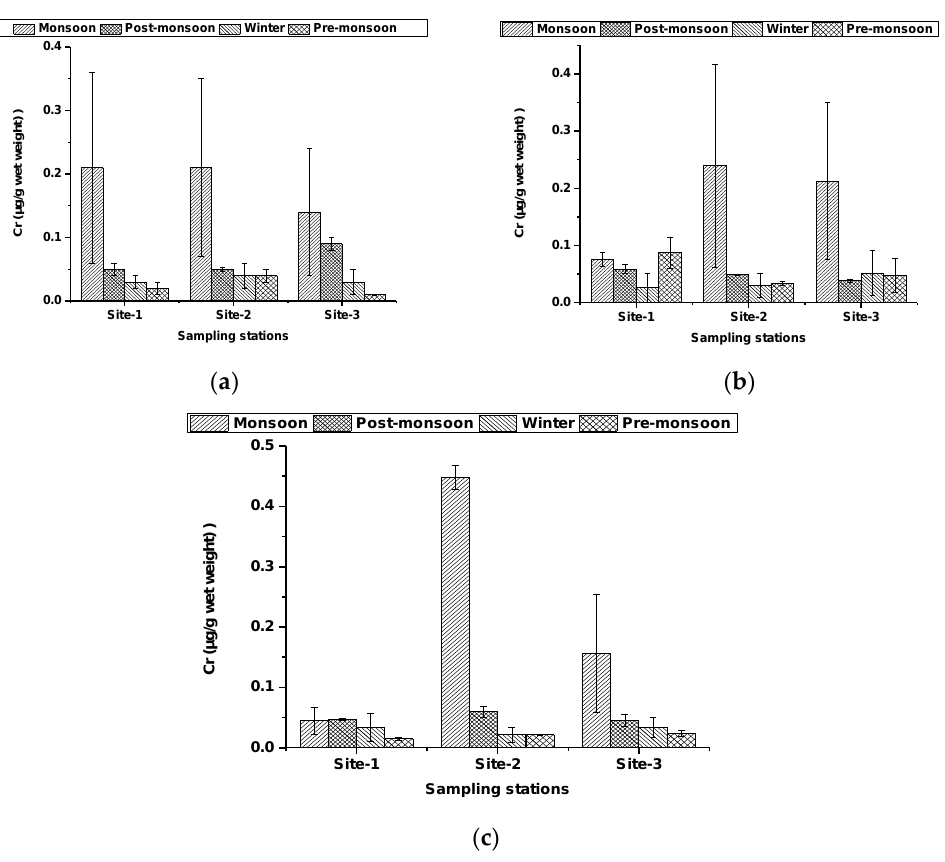
Figure 3. ( a ) Concentrations of Chromium (Cr) in L. rohita fish species; ( b ) Concentrations of Chromium (Cr) in C. cirrhosus fish species; ( c ) Concentrations of Chromium (Cr) in L. calbasu fish species.